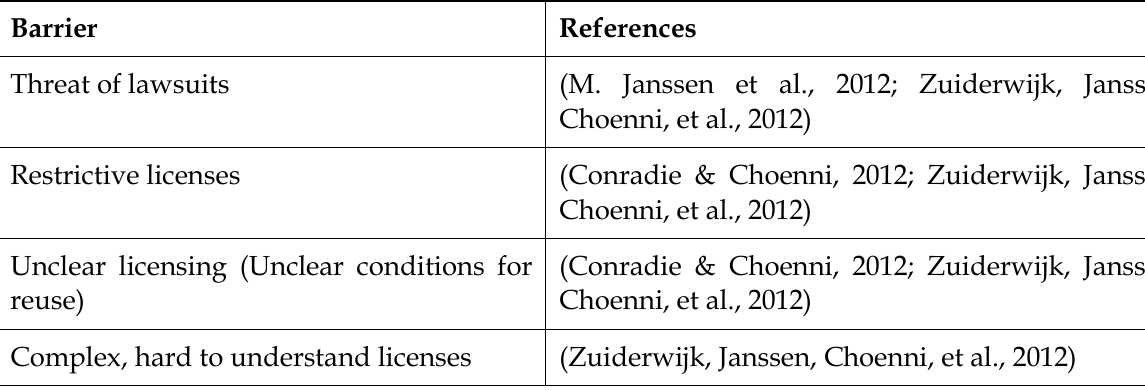
Table 3: User Legal Barriers (Source: Authors)